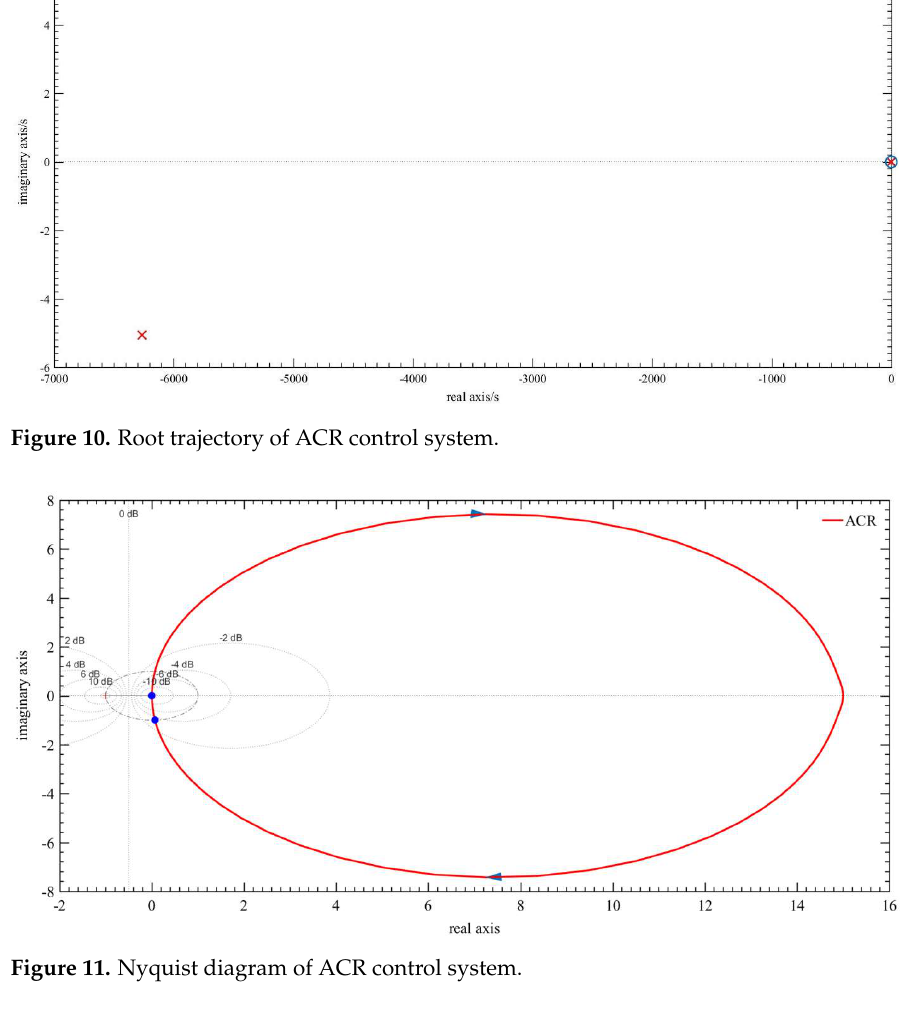
Figure 11. Nyquist diagram of ACR control system.